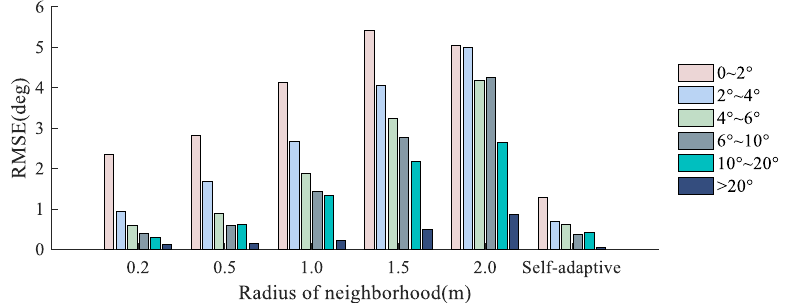
Figure 14. Accuracy of surface slope estimation with grades of slope value in different neighborhood point selection radii. Table 5. Root mean square error of wave surface slope estimation in different intervals.